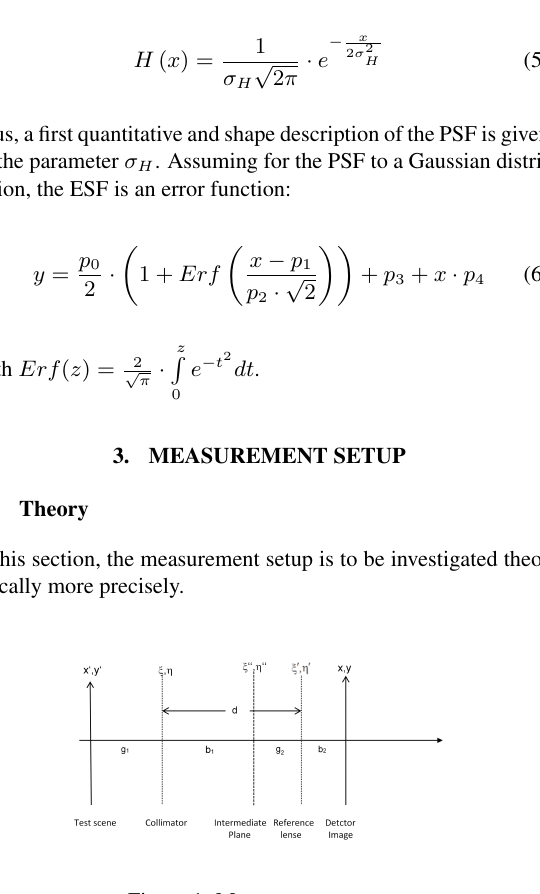
Figure 1. Measurement